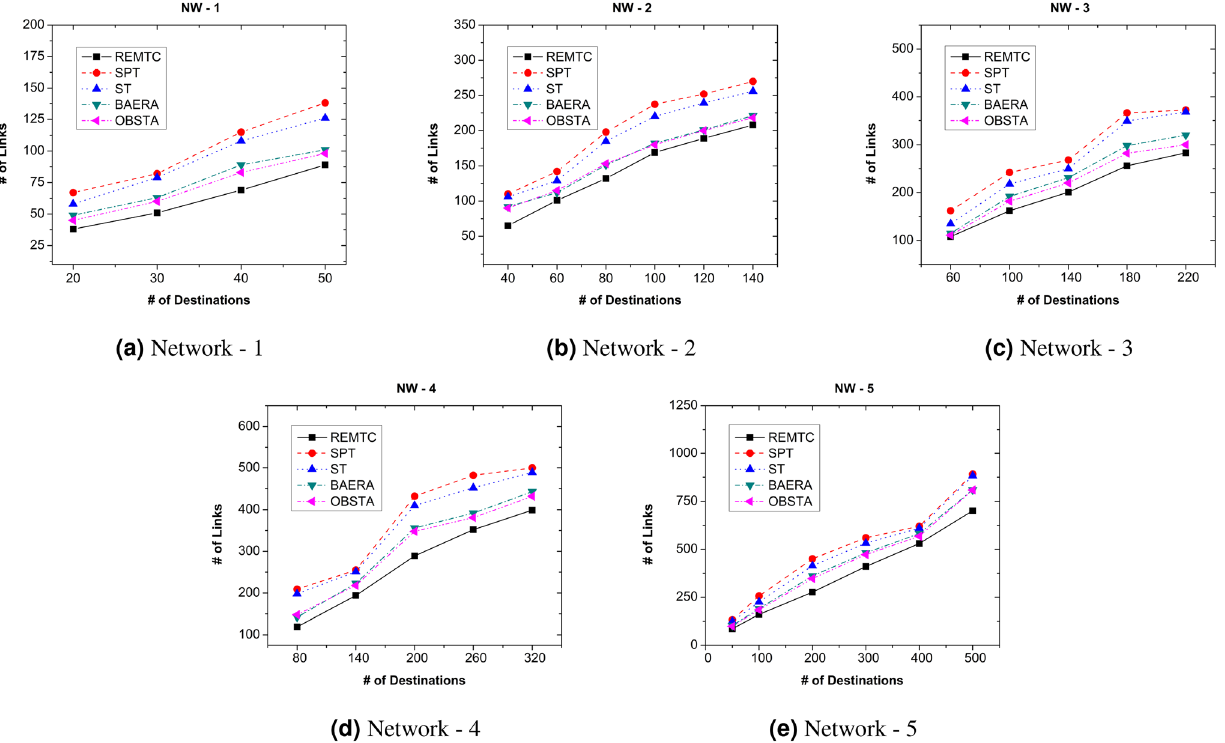
Figure 5. Number of links used by the proposed method over five